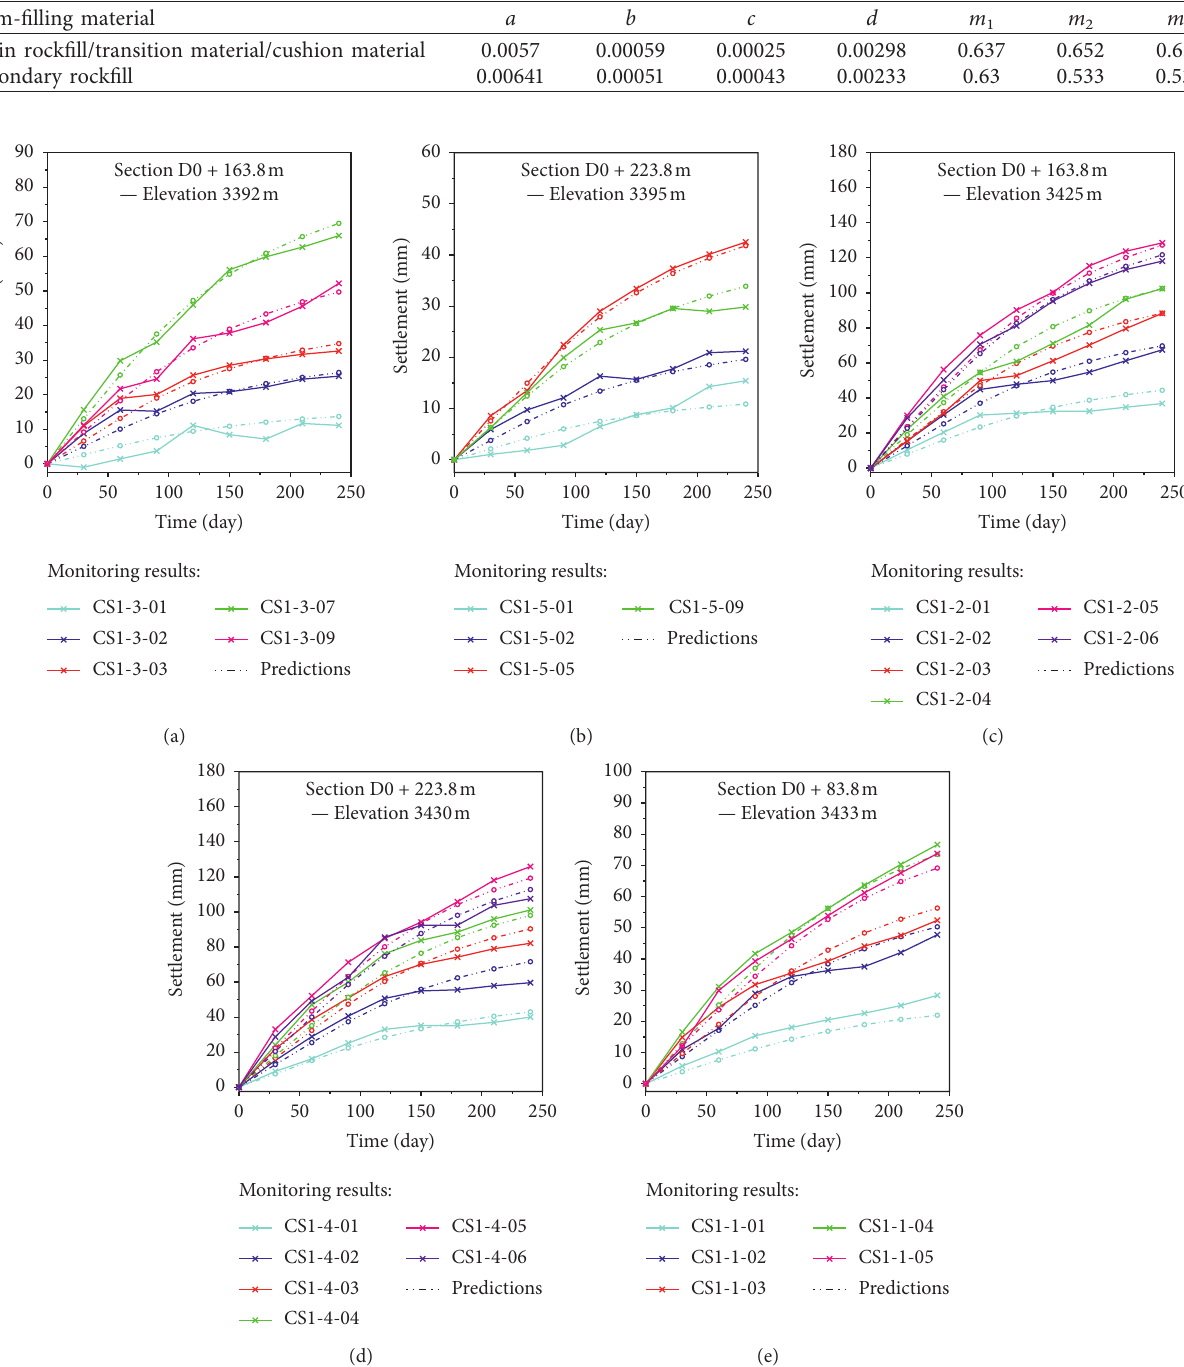
Figure 6: Comparison of the prediction and the monitoring results of settlement model in monitoring points within eight months after the completion of the Xujixia